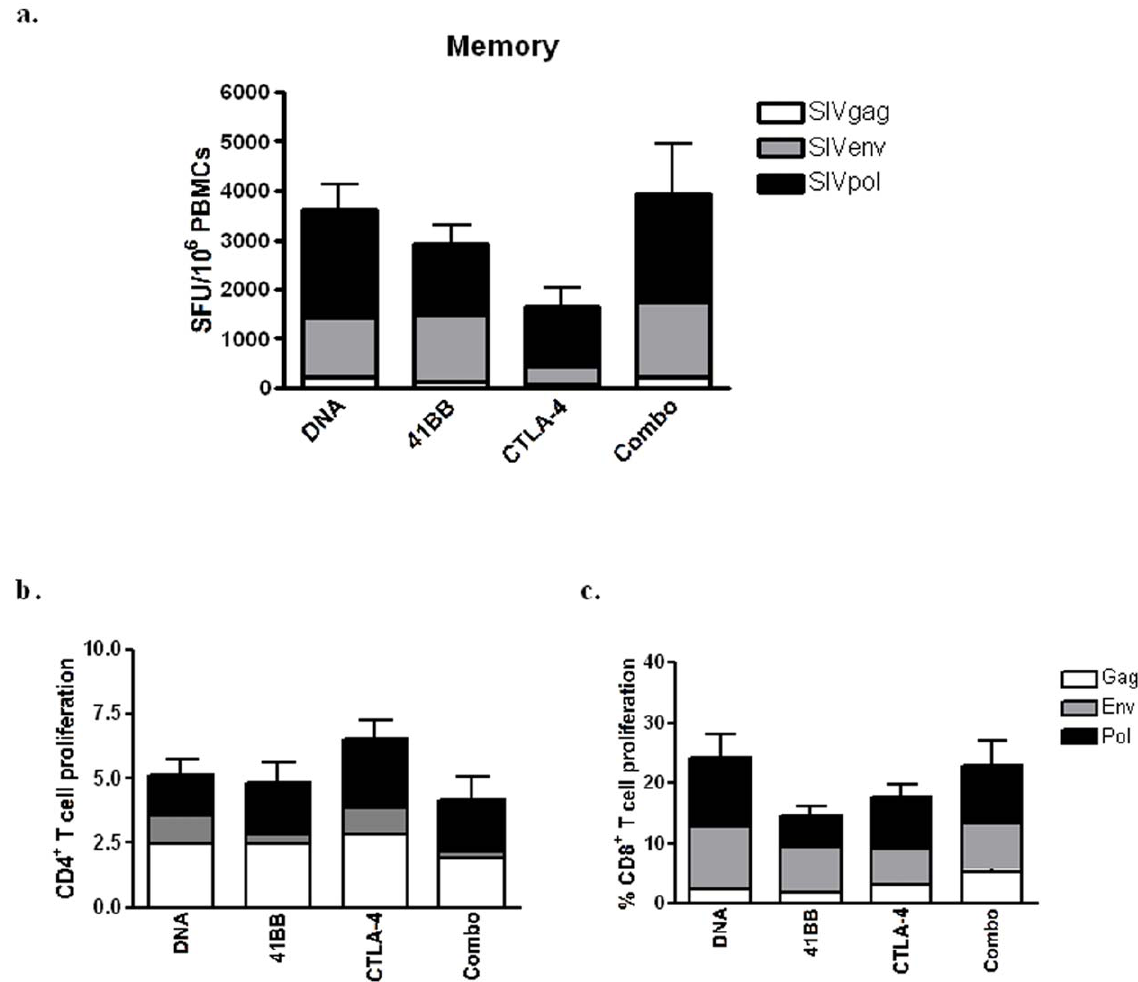
Figure 5. Maintenance of memory T cells. PBMCs were collected from immunized macaques at 10 months following a fourth immunization to evaluate memory IFN- c responses. Cells were then stimulated with SIVmac239 gag (white bars), env (grey bars), and pol (black bars) peptide pools in 18-hour IFN- c ELISpot assays ( a ). PBMCs were also labelled with CFSE and stimulated with pooled SIVmac239 gag (white bars), env (grey bars), and pol (black bars) peptides for 5 days. Cells were then stained for phenotypic markers and analyzed by flow cytometry to determine the proliferative response to each antigen ( b and c ). For both ELISpot and proliferation assays, error bars represent mean responses 6 SEM.